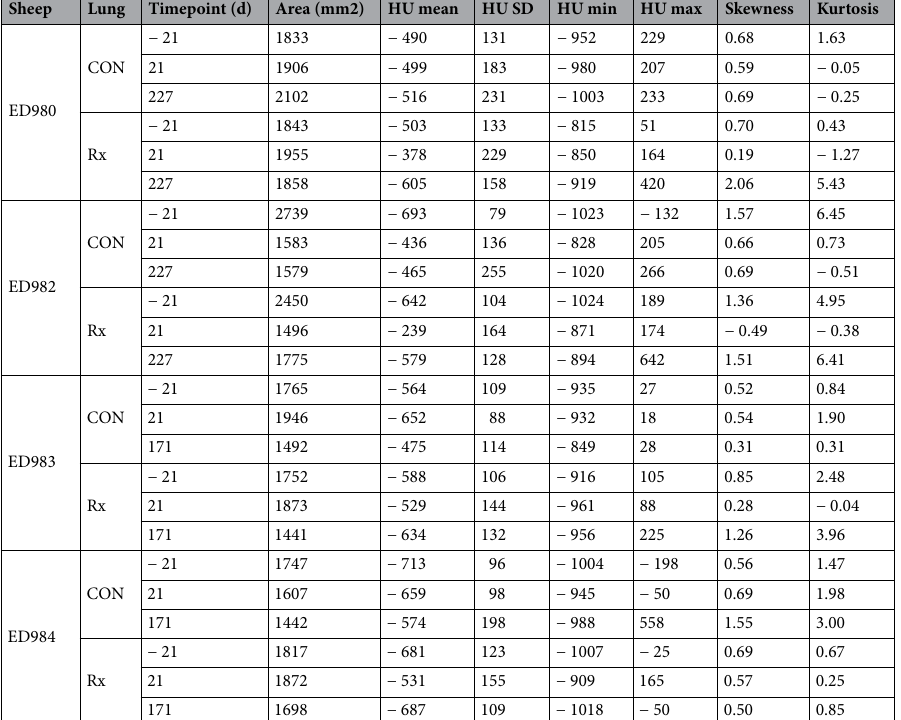
Table 3. 1st order statistics describing the distribution of individual pixel values in lung slice images derived from CT scan images of radio-exposed (Rx) and contralateral control (CON) lung at time points prior to (d-21), and following radiation exposure (d21, and